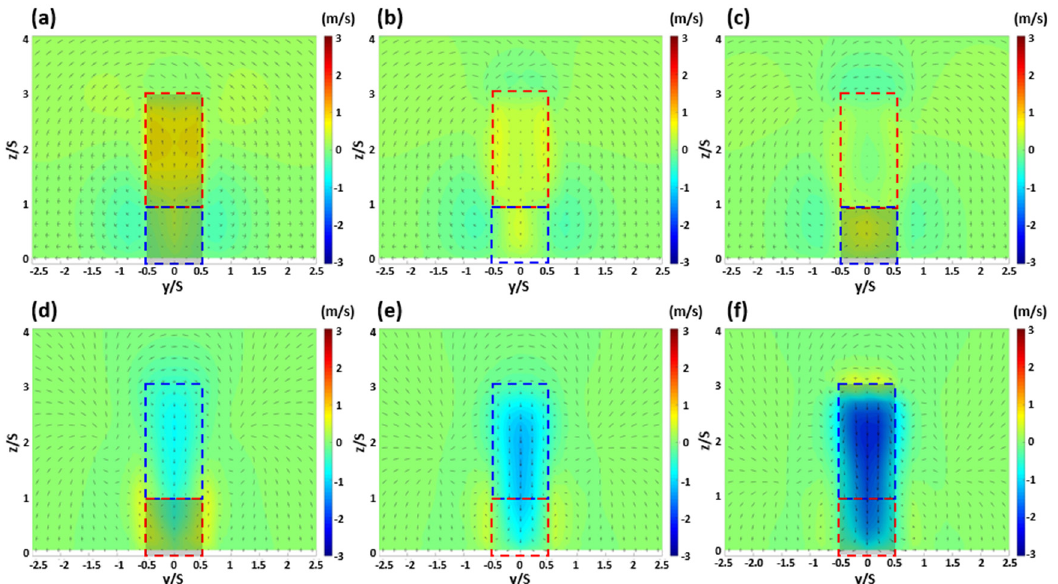
Figure 9. Wind field and vertical wind component of the first canyon (upper panel) and the second canyon (lower panel); x/S = − 1.4 ( a ), − 1.0 ( b ), − 0.6 ( c ), 0.6 ( d ), 1.0 ( e ), 1.4 ( f ) with numerical simulations in the case of step-down to step-up canyons; shallow canyons. The windward buildings (red dotted box); leeward buildings (blue dotted box) of each canyon.